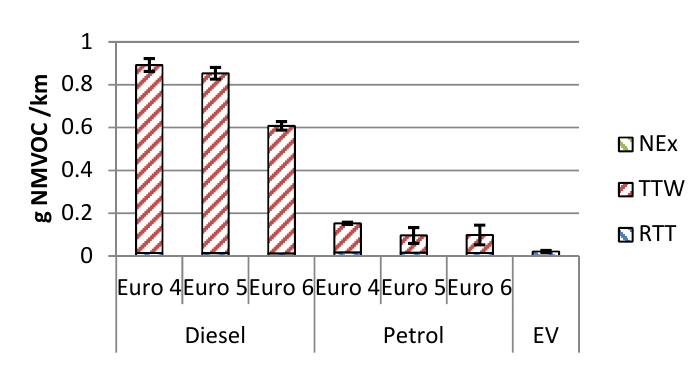
Figure 8. Photochemical oxidant formation impacts.